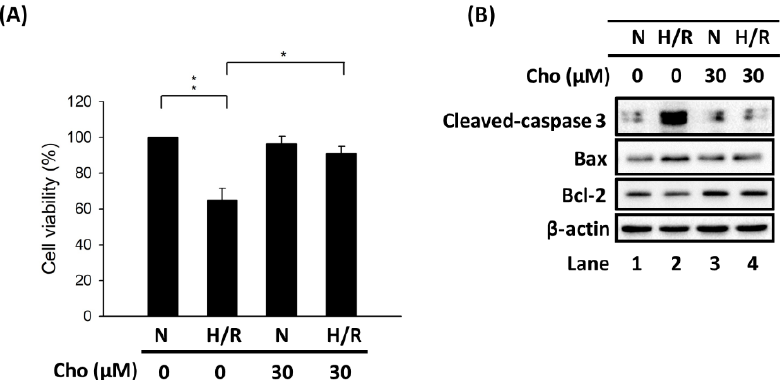
Figure 1. Chrysophanol alleviated H/R-induced cell viability. ( A ) Cell viability was determined using WST-1 assays for the indicated groups of cells. All data are presented as mean ± SD. n = 3. * p < 0.05. ** p < 0.01. ( B ) Changes in the expression of cleaved-caspase 3, Bax and Bcl-2. β -actin was used as an internal control. Cho: Chrysophanol. H/R: Hypoxia/reoxygenation. N: Normoxia.